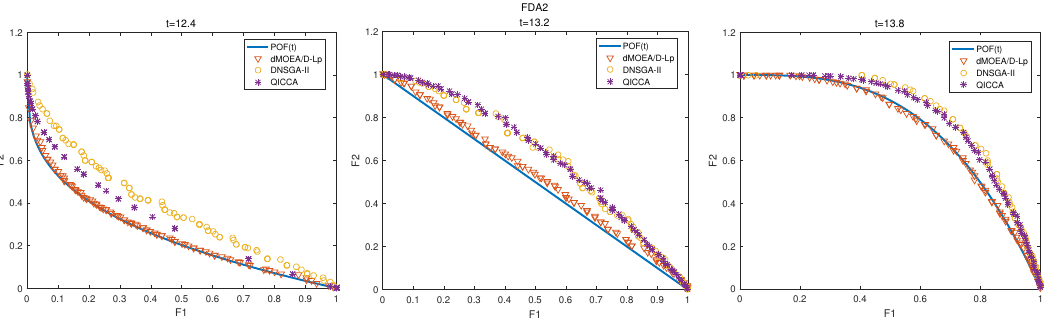
Figure 4. Solution sets obtained by three algorithms at different times on FDA1 in case of τ T = 25, n T = 5.